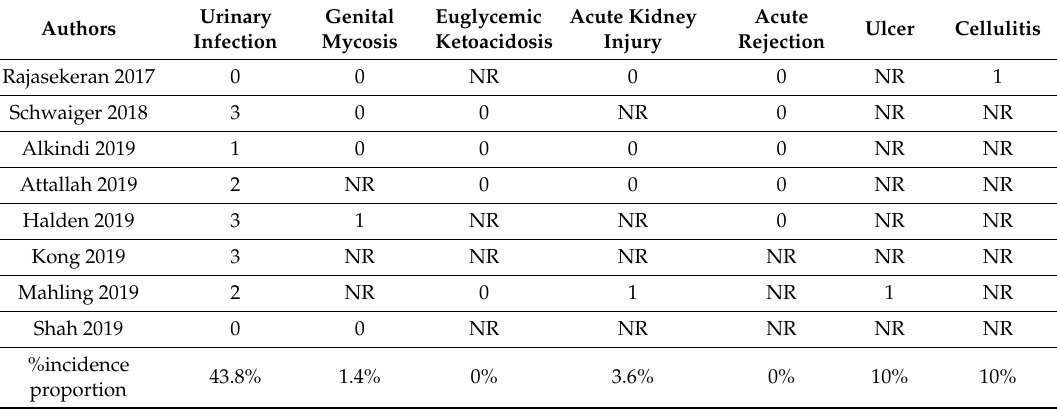
Table 4. Safety profiles of SGLT-2 inhibitors among kidney transplant recipients with post-transplant diabetes